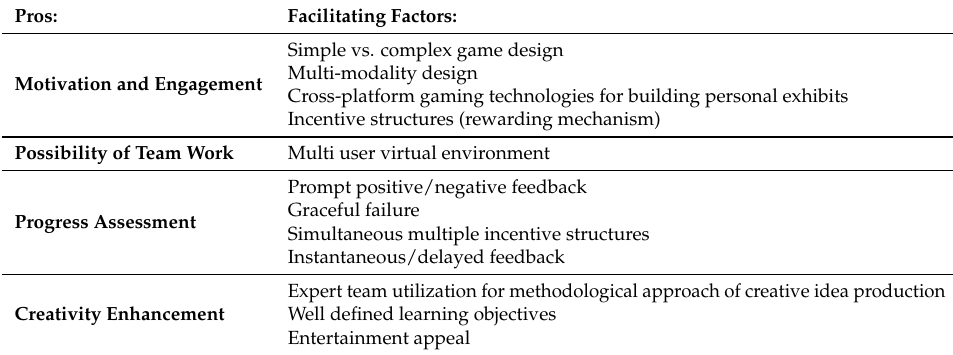
Table 1. Categorization of positive aspects and facilitating factors of game-based learning. Pros: Facilitating